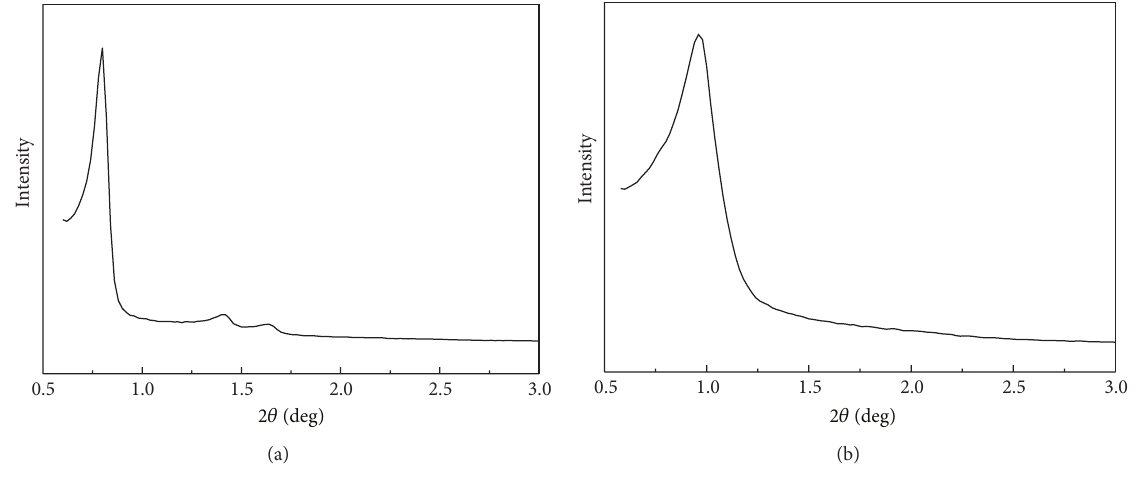
Figure 1: Powder XRD patterns of (a) SBA-15 and (b)